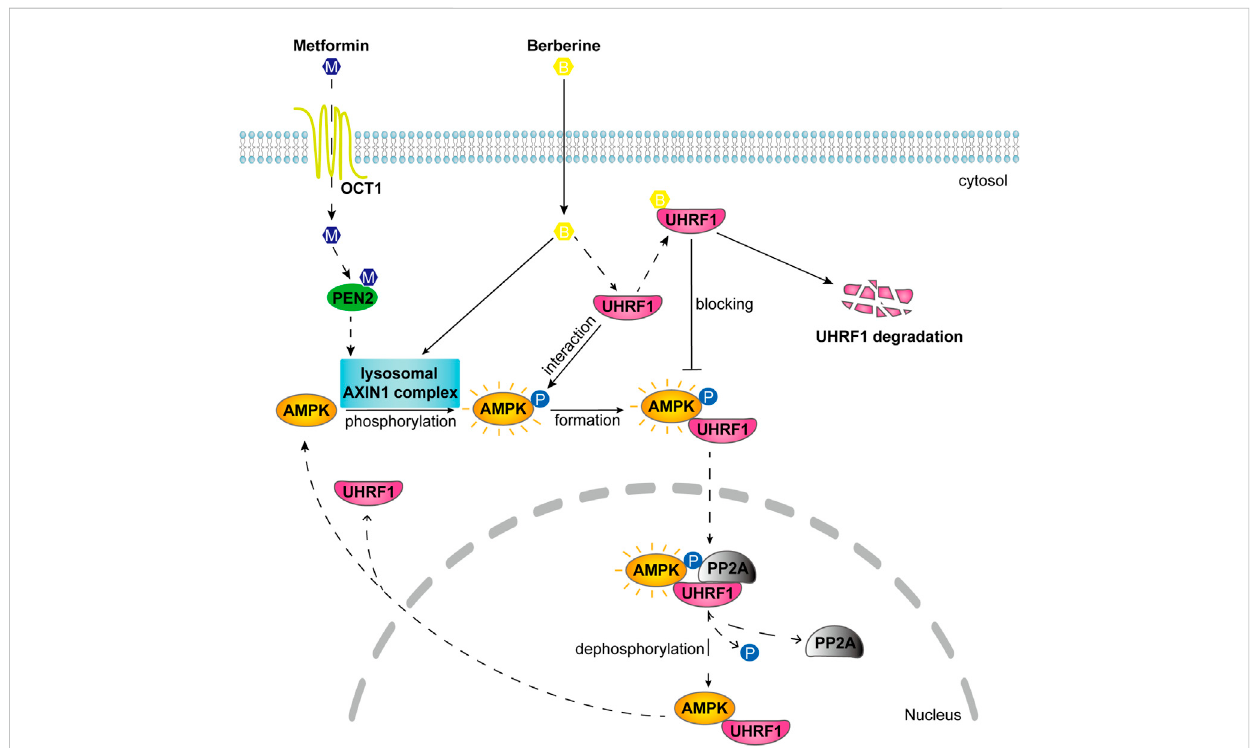
Schematic diagram illustrates the different mode of action on AMPK activation between BBR and metformin. Metformin activates lysosomal AMPK throughPEN2andAXIN1aftertransportintothecellularcytosol(Zhangetal.,2016;Maetal.,2022).BBRactivatedlysosomalAMPKthroughAXIN1butnot PEN2. After interaction with AMPK α , UHRF1 recruits PP2A to dephosphorylate AMPK in the nucleus (Xu et al., 2022). And BBR is reported to bind with UHRF1 (Gu et al., 2020). BBR inhibited the dephosphorylation process of AMPK by reducing the interaction of UHRF1 with AMPK α 1 and promoting UHRF1